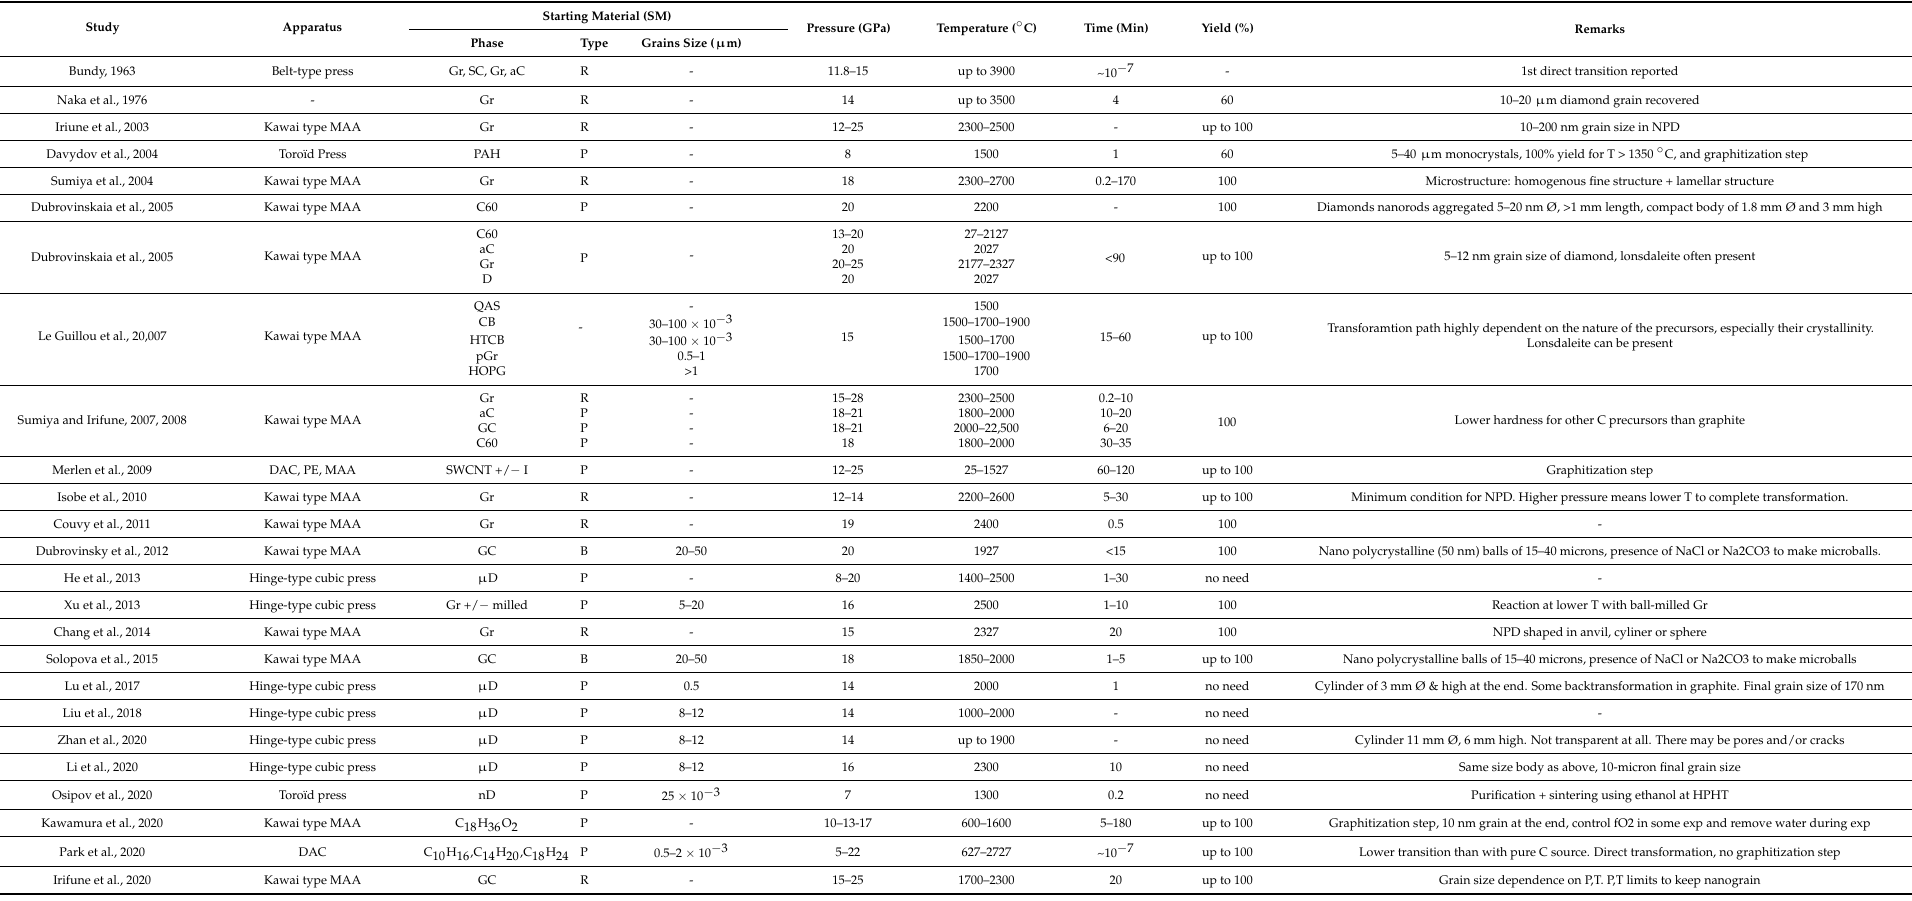
Table 2. Experimental conditions for the synthesis and/or sintering of binderless